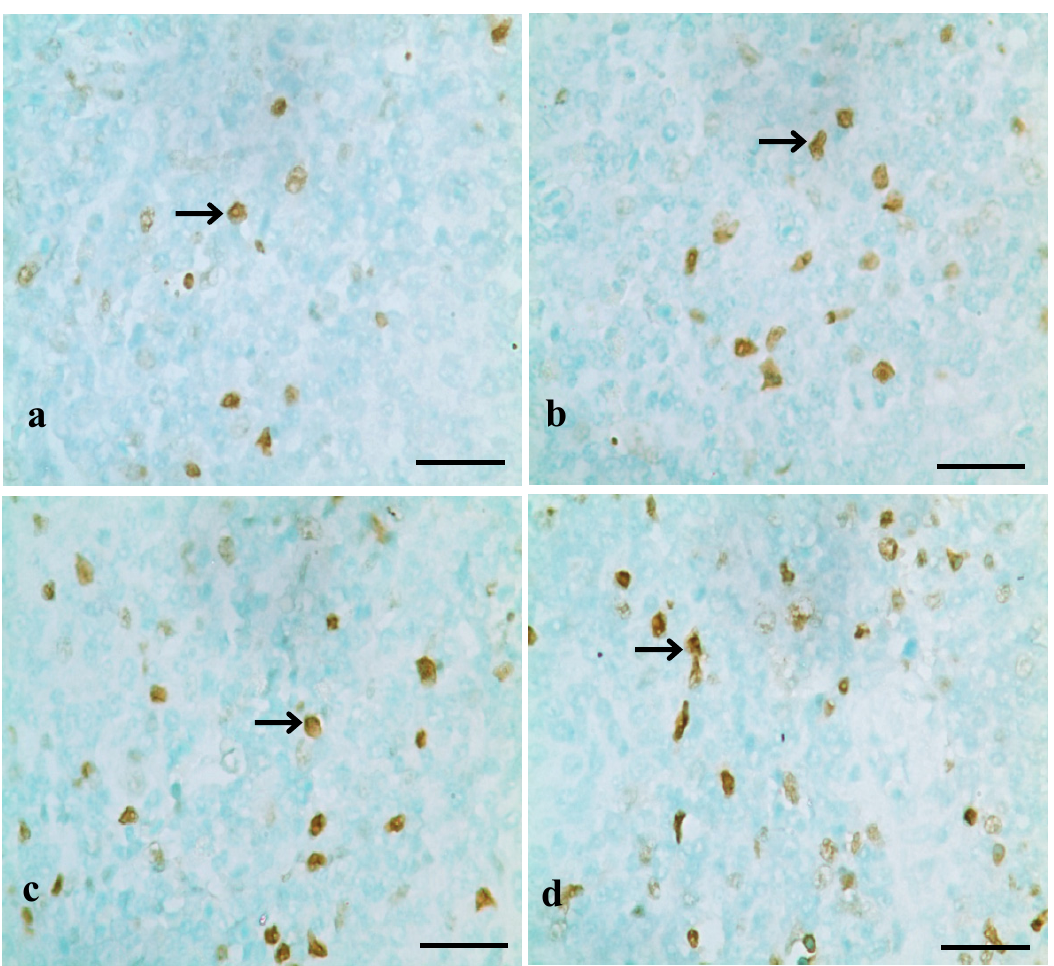
Figure 1. Positive cells stained by TUNEL in the spleen at 14 days of